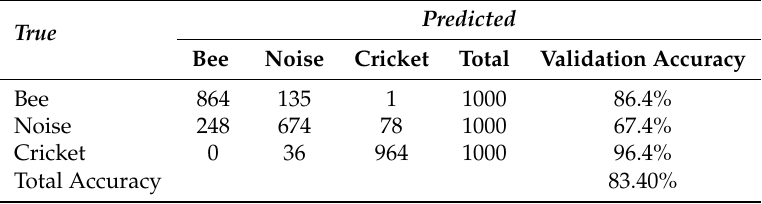
Table A14. Confusion matrix for ConvNet 3 with receptive field n = 80 on BUZZ2 validation dataset.